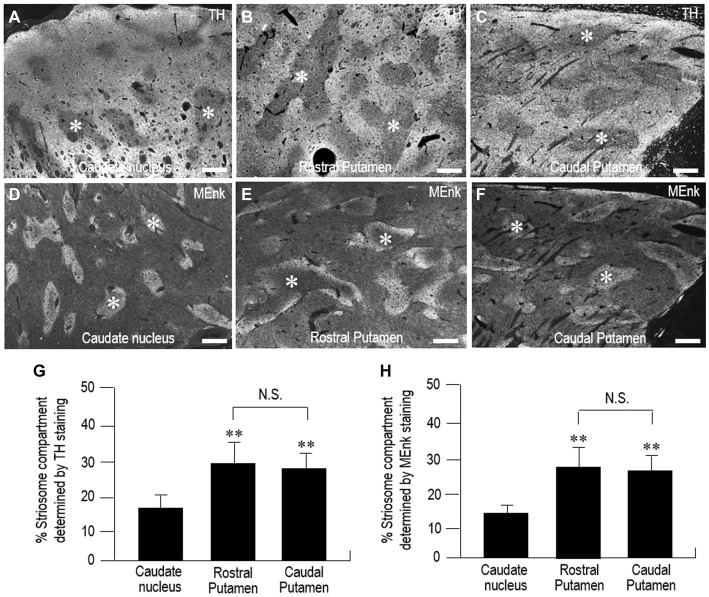
Morphometric analysis of the percentage of the striatum occupied by the striosome compartment in the human neostriatum. (A–F) Gray-scale-converted microscopic images of striatal areas stained with fluorescence for TH (A–C) and MEnk (D–F) in the CN (A,D), rostral putamen (B,E), and caudal putamen (C,F). Asterisks indicate examples of striosomes. Scale bars: 1 mm. (G) Measurements of the percentage of the striatum occupied by the striosome compartment identified by TH-immunostaining in the CN, rostral putamen, and caudal putamen. Data represent means ± SEM (bars), n = 25. **indicates P < 0.01 vs. CN; N.S. (not significant) indicates P > 0.05, Rostral Putamen vs. Caudal Putamen. (H) Measurements of the percentage of the striatum occupied by the striosome compartment identified by MEnk-immunostaining in the CN, rostral putamen, and caudal putamen. Data represent means ± SEM (bars), n = 25. **indicates P < 0.01 vs. CN; N.S. (not significant) indicates P > 0.05, Rostral Putamen vs. Caudal Putamen.